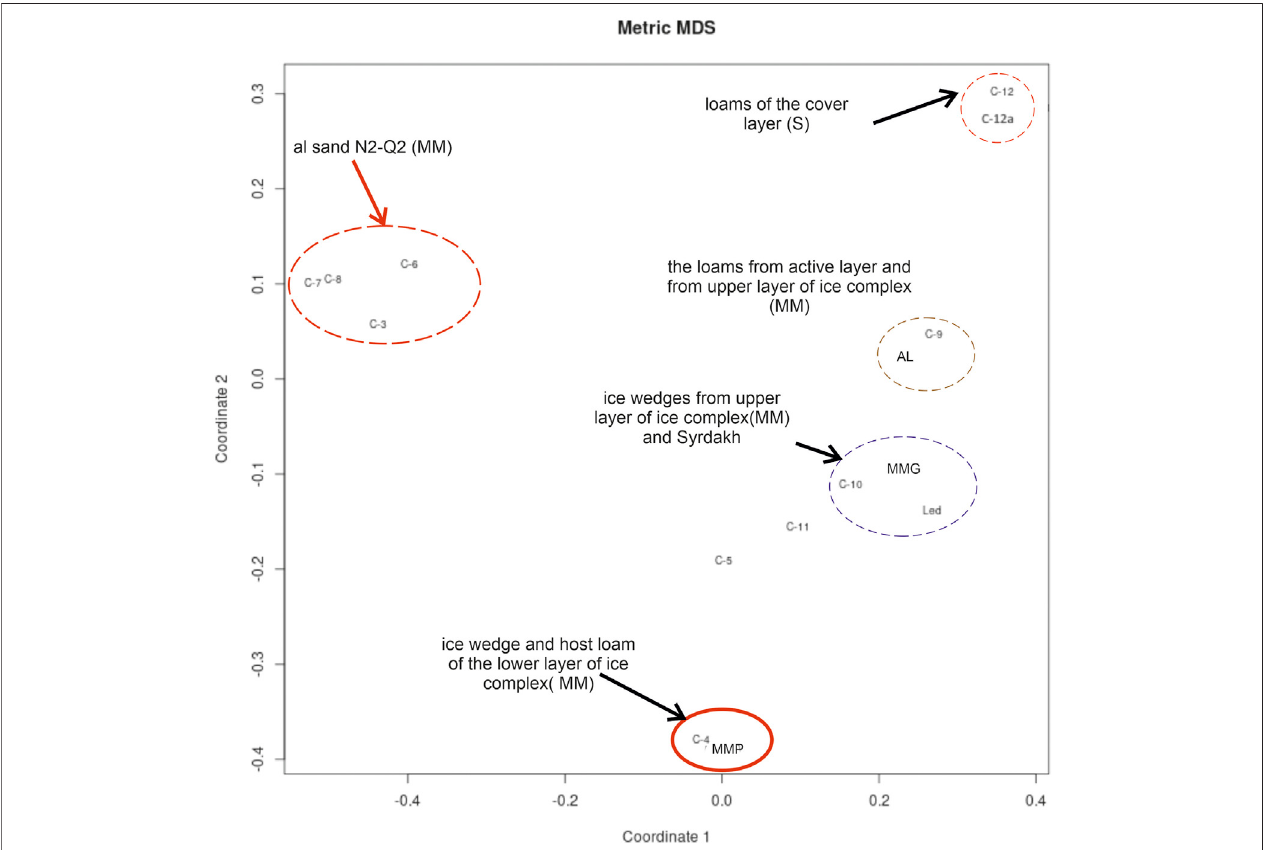
FIGURE 11 | Principal coordinate analysis (PCoA) scores plot of beta diversity based on UniFrac distance metric. MM for Mamontova Gora, S for Syrdakh. The samples AL, MMG and MMP correspond to previously studied samples of the ice complex of Mamontova Gora: an active layer (AL), an ice wedge of the upper (MMG) and lower horizons